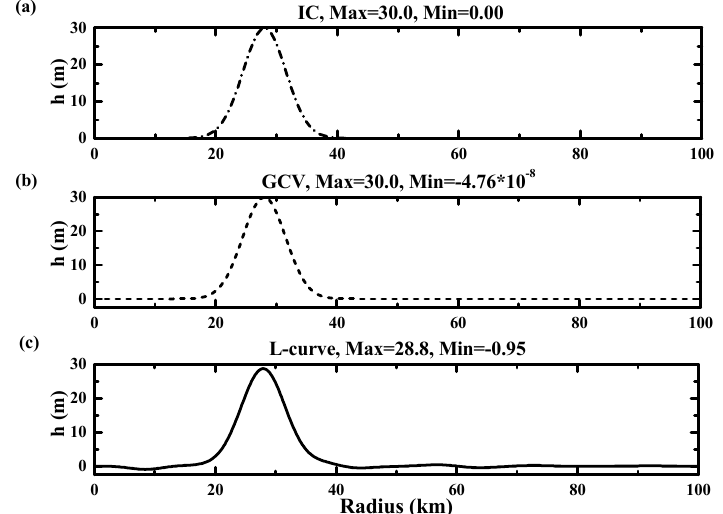
Figure 3. Radial distributions of the perturbation height at initial time: ( a ) the result of the given initial condition, ( b ) the inverse result based on the GCV method; ( c ) the inverse result based on the L-curve method.